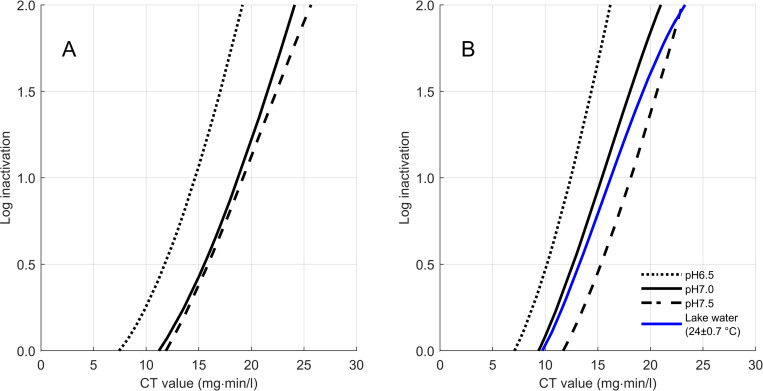
CT values required to inactivate S. mansoni cercariae at 20°C (Fig 3A) and 27°C (Fig 3B) in bottled water samples with pH 6.5, 7.0 or 7.5. Fig 3B also shows CT values under field conditions using water and snails collected from Lake Victoria.